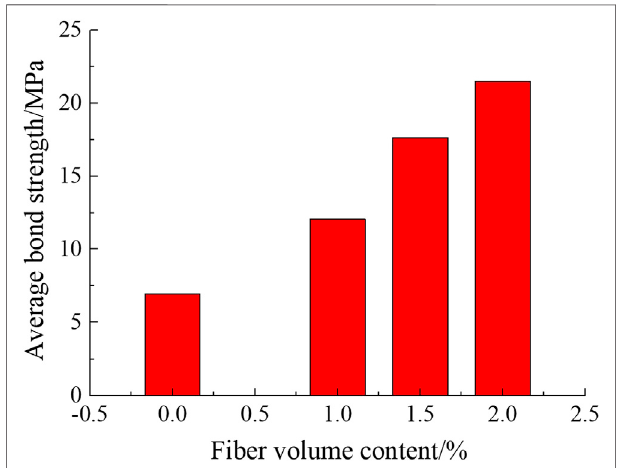
FIGURE 11 | Effect of fi ber volume content on average bond